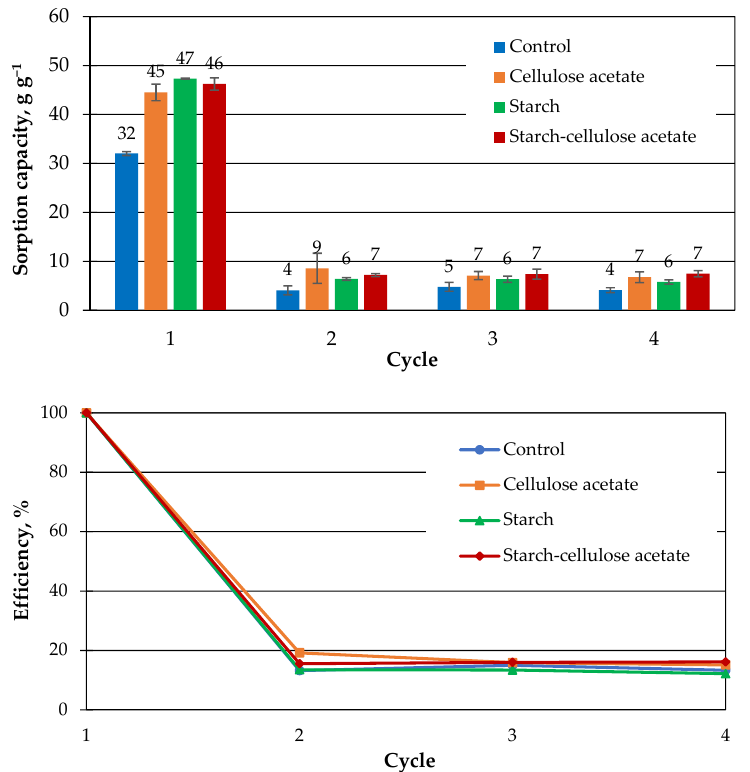
Figure 7. Results of the aerogels with different cross-linkers maximum crude oil-sorption capacity ( upper figure ) and reuse efficiency of the samples on crude oil by each cycle ( lower figure ). The aerogels with cellulose acetate as a cross-linking agent had a slightly lower